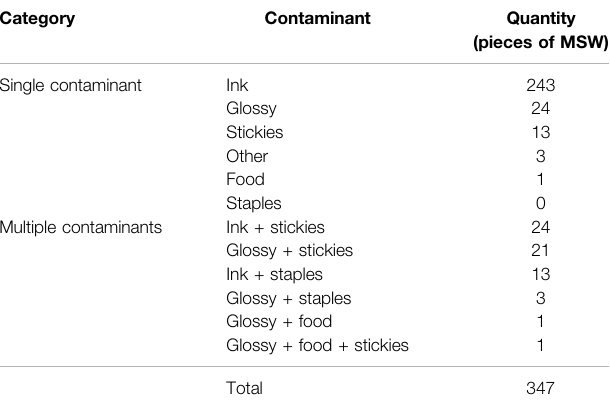
TABLE 1 | Quanti fi cation of mixed paper intrinsic